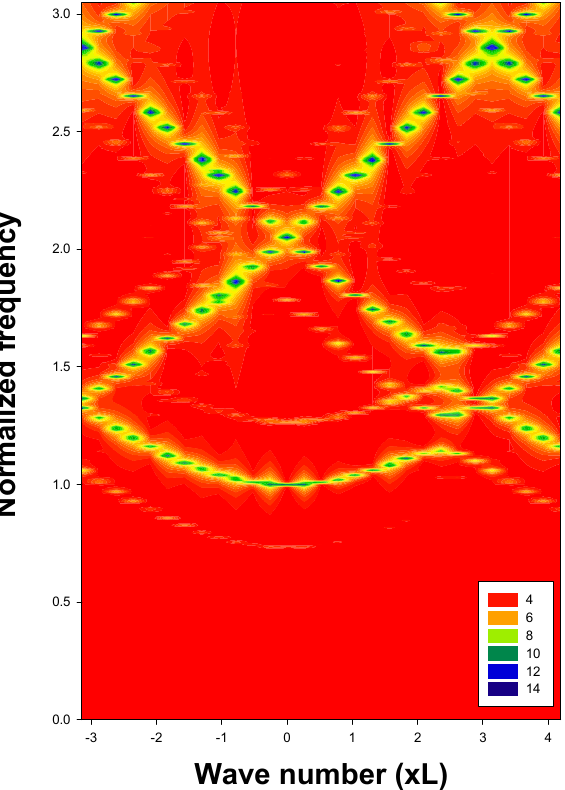
Figure 5. Band structure of the mechanical model system of Figure 2 calculated using the Spectral Energy Density (SED) method. The band structure is reported as a contour plot of the natural logarithm of the SED (color bar) versus normalized frequency and reduced wave number. The frequency is normalized to the lowest value of unperturbed band, namely 1.507 × 10 5 Hz. The horizontal axis is extended to the right beyond the first Brillouin zone [ −π , π ] to highlight the asymmetry and therefore the modulation-induced symmetry breaking of the band structure. The brighter branches correspond to the usual zeroth-order type wave ( e i ω 0 p k ` g q τ 0 ). The fainter branches parallel to the brighter ones are characteristic of first-order waves ( (cid:1857)